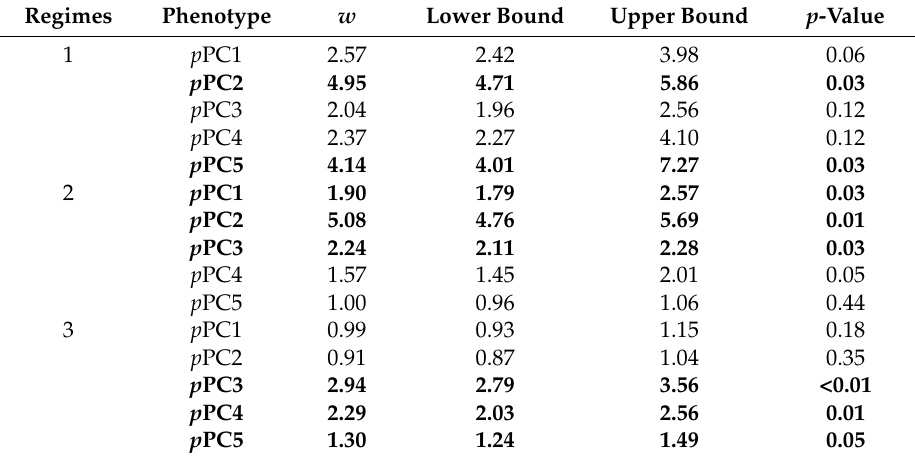
Table 3. Test and quantification of convergence, based on the Wheatsheaf index, of skull shape for convergent regimes of frugivorous bats of Stenodermatinae and Carollinae subfamilies of Phyllostomidae. Wheatsheaf indices ( w ) with associated 95% confidence intervals for shape variables of skull in each convergent regime. p -values from analyses are also provided, and significant ( p < 0.05) values are highlighted in bold. p PC1 represented skull size, p PC2 represented relationship between palatal width and post-palatal length (PPL = 0.772), p PC3 represented post-palatal length, p PC4 represented relationship between palatal width and post-palatal length, and p PC5 represented relationship between zygomatic breadth and post-palatal